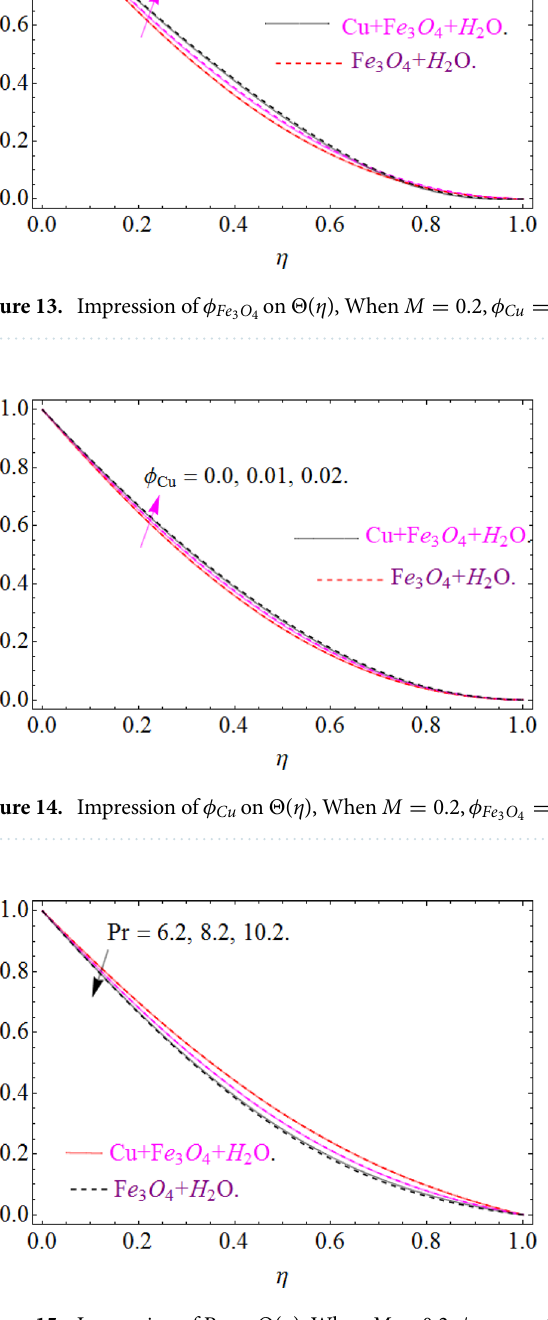
Figure 15. Impression of Pr on Θ( η ), When M = 0.2, φ Fe 3 O 4 = 0.4, φ Cu = 0.2, Re ω = 0.3, Re � = 0.13